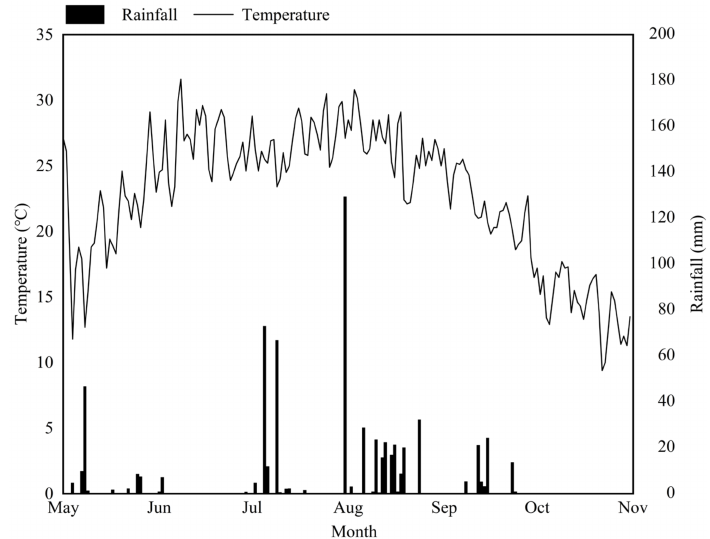
Figure 3. The rainfall and temperature during okra growth period in 2020.